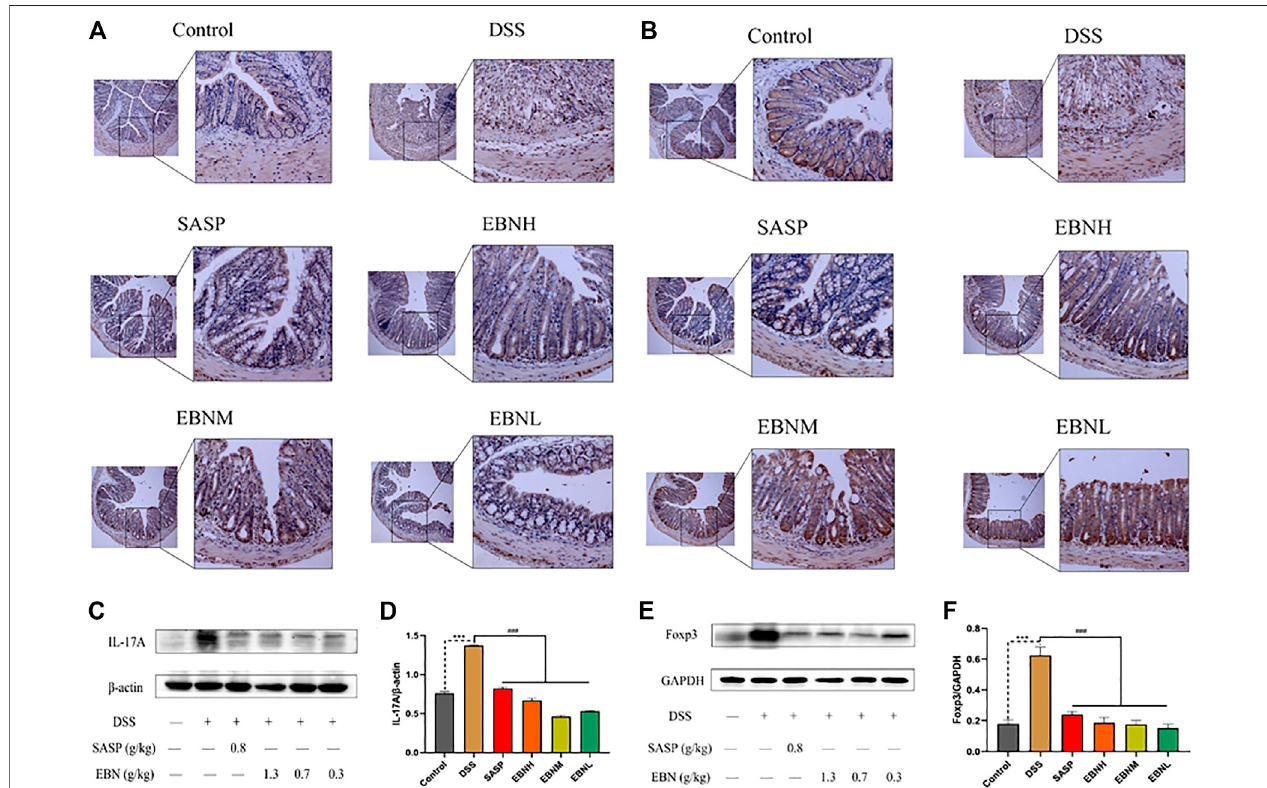
FIGURE 6 | Effects of EBN pretreatment on the expression of Th17 and Treg cell-associated proteins in colonic tissues. (A,B) Effects of EBN on the expression of IL-17AandFoxp3incolonictissuesdetectedbyIHC(100 × ). (C,D) EffectofEBNonIL-17Aexpressionincolonictissuesofmicewithcolitis. (E,F) EffectofEBNonFoxp3 expression in colonic tissues of mice with colitis. *** P < 0.001 compared with the control group; # P < 0.05, ## P < 0.01 and ### P < 0.001 compared to the DSS group ( x ± S , n (cid:2)